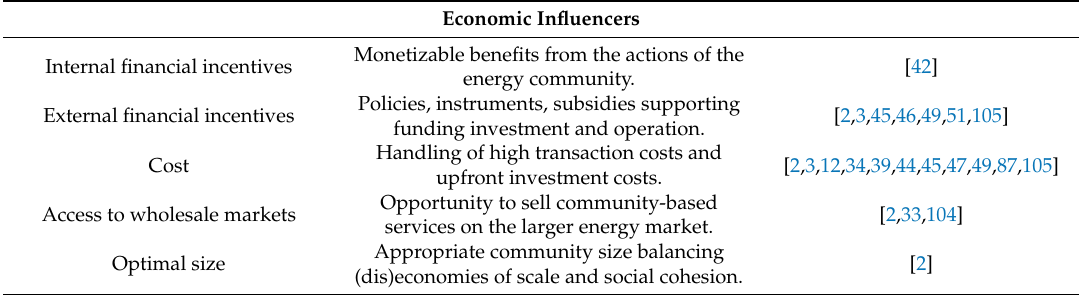
Table 4. Economic influencer progression factors.